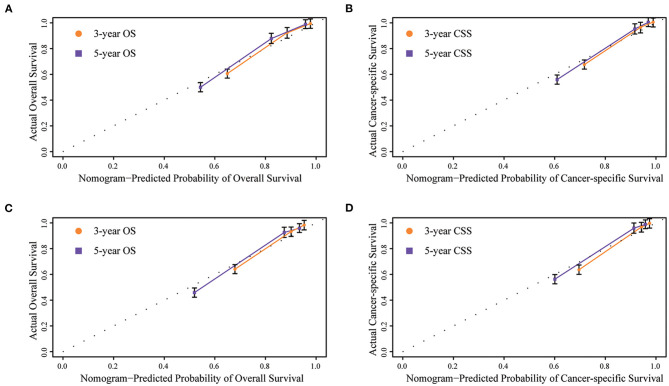
Internal calibration plots of (A) 3- and 5-year overall survival in training group, (B) 3- and 5-year cancer-specific survival in training group, (C) 3- and 5-year overall survival in validation group, (D) 3- and 5-year cancer-specific survival in validation group. The dashed line represents an excellent match between nomogram predicted survival (X-axis) and actual survival outcome (Y-axis). A plot along the dashed line indicates a perfect calibration model.